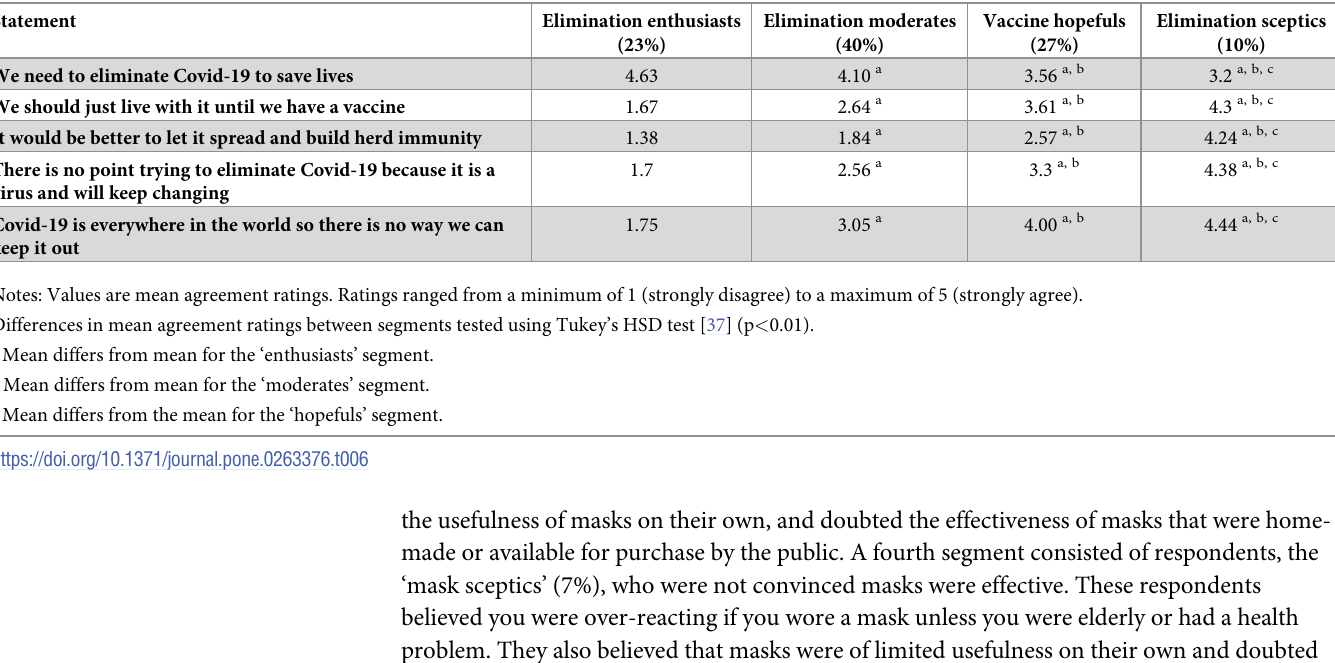
Table 6. Belief segments for eliminating Covid-19.